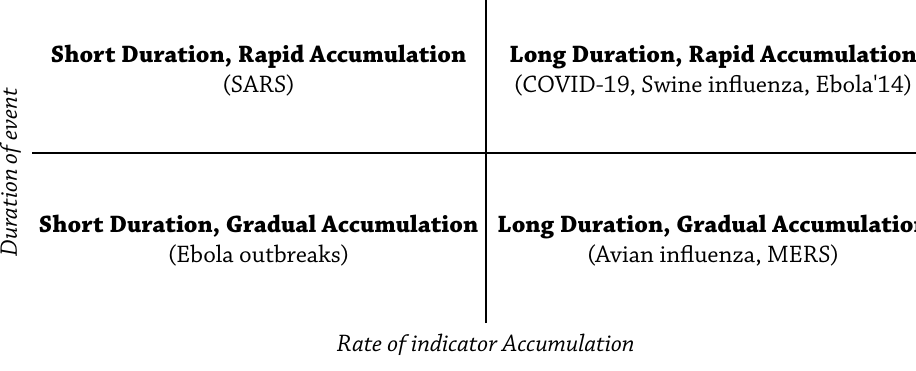
Figure 1: The Indicator-Event